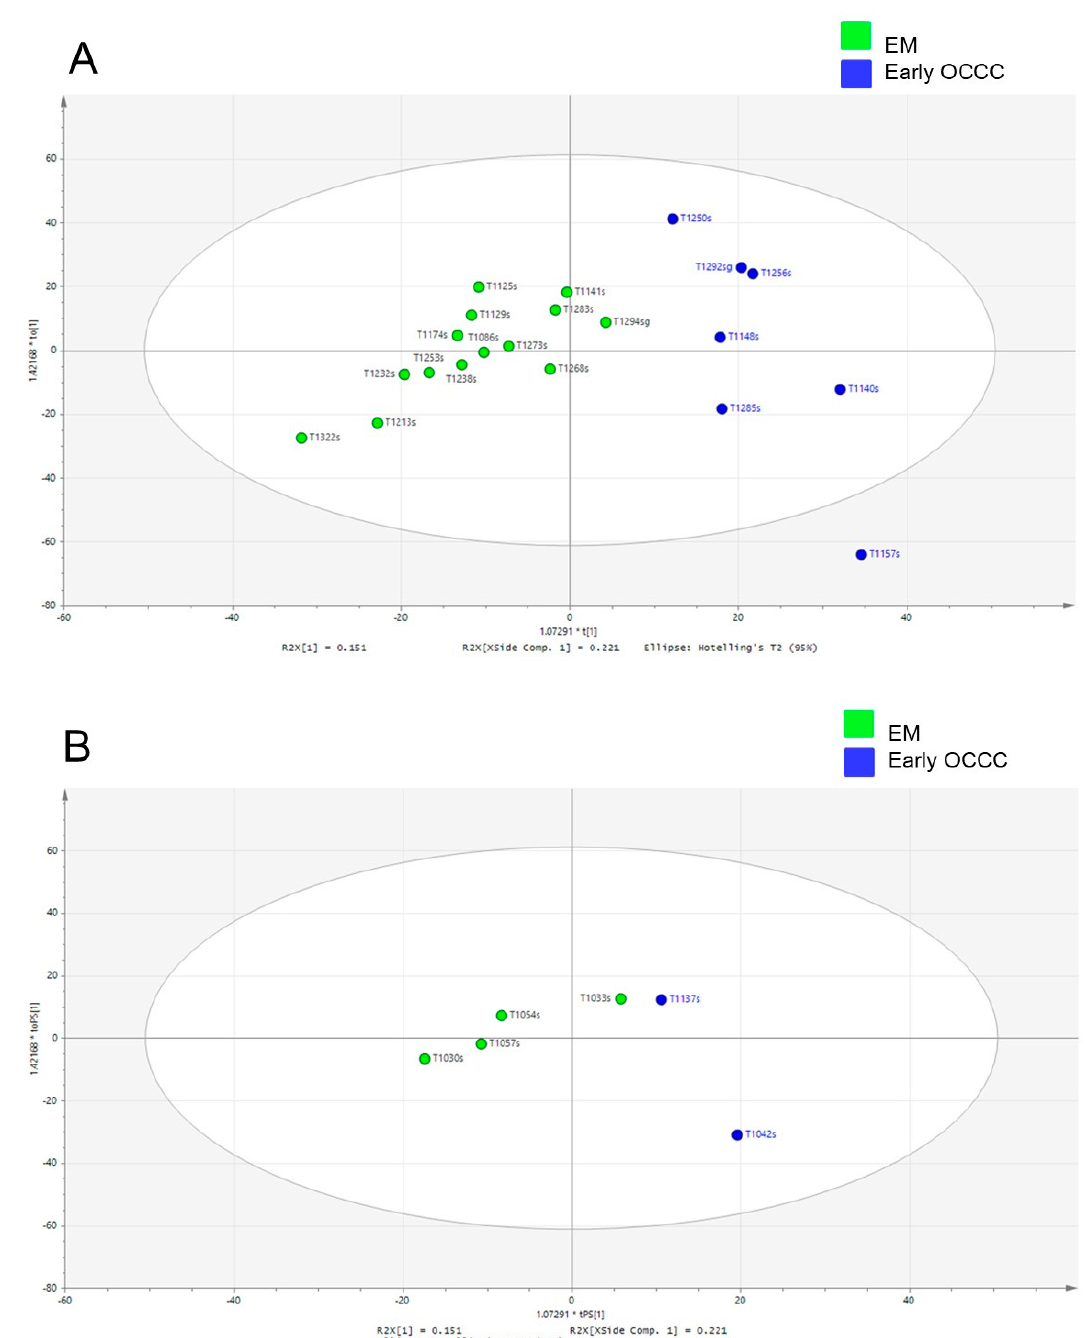
Figure 5. Glycopeptide spectral data in early-stage OCCC group and endometrioma group. ( A ) OPLS-DA scatter plot based on the same samples as in panel B. Green dots are endometrioma samples and blue dots are early-stage OCCC patients. The ellipse represents 95%CI. ( B ) Scores plots of the OPLS-DA prediction model for validation set. Green dots are endometrioma samples and blue dots are early-stage OCCC. The ellipse represents 95% confidence interval. Abbreviations: OCCC, ovarian clear cell